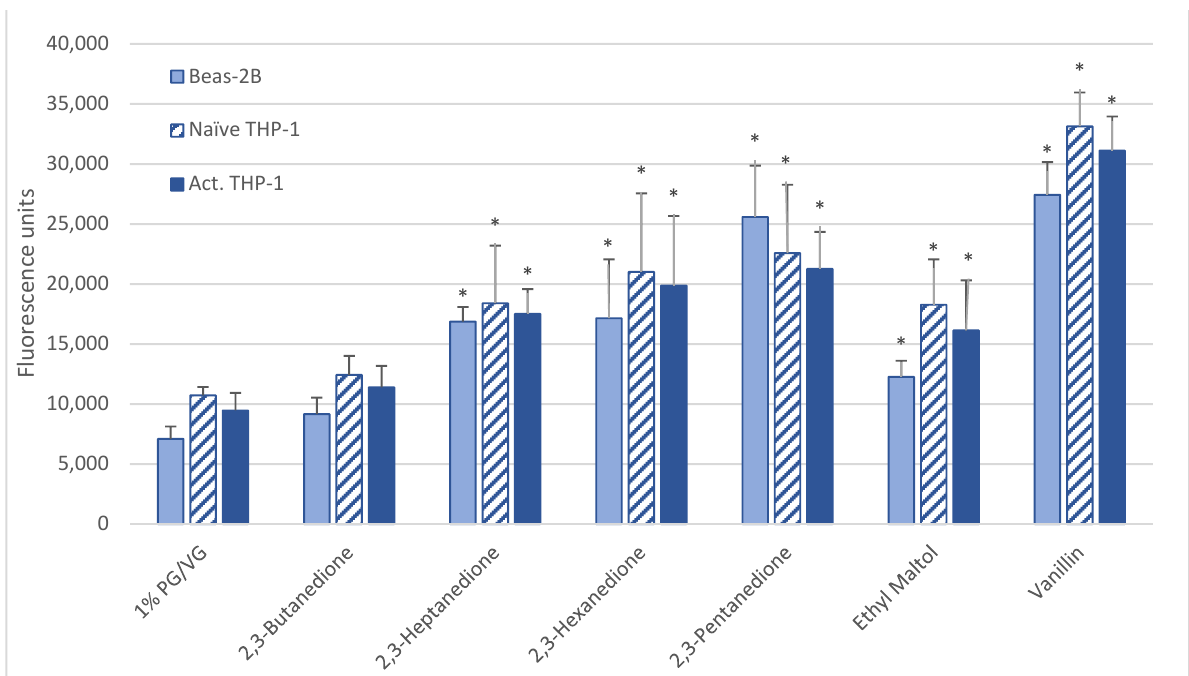
Figure 2. ROS measured with cell-permeable dye 2 ′ ,7 ′ -dichlorofluorescin diacetate after 6 h treatment with 1000 µM of selected flavoring chemicals. Data are presented as means +/ − standard error. Significance: * p < 0.05 as compared with vehicle control (1%PG/VG).